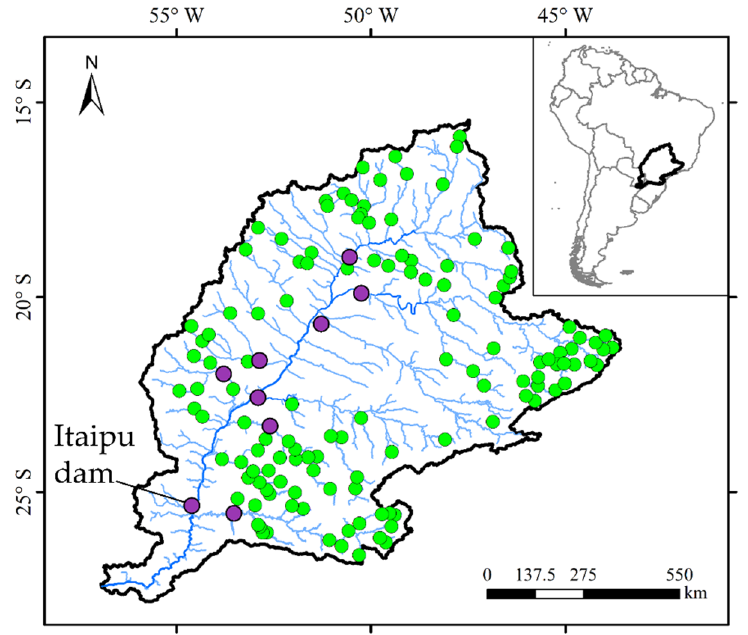
Figure 2. The Upper Paraná River Basin in South America. The 136 river gauges used are presented as green circles or highlighted as purple circles for nine gauges of interest. The location of the Itaipu dam is also presented.